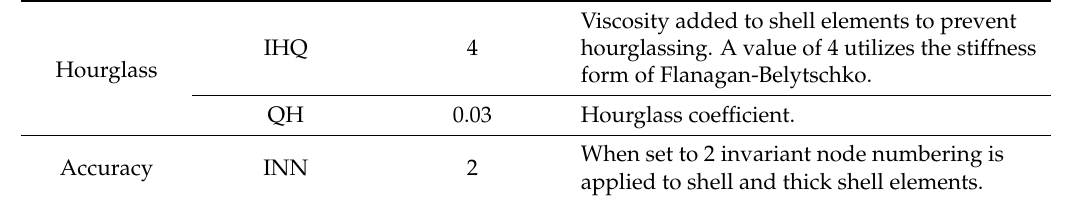
Table 5. Additional control section parameters.